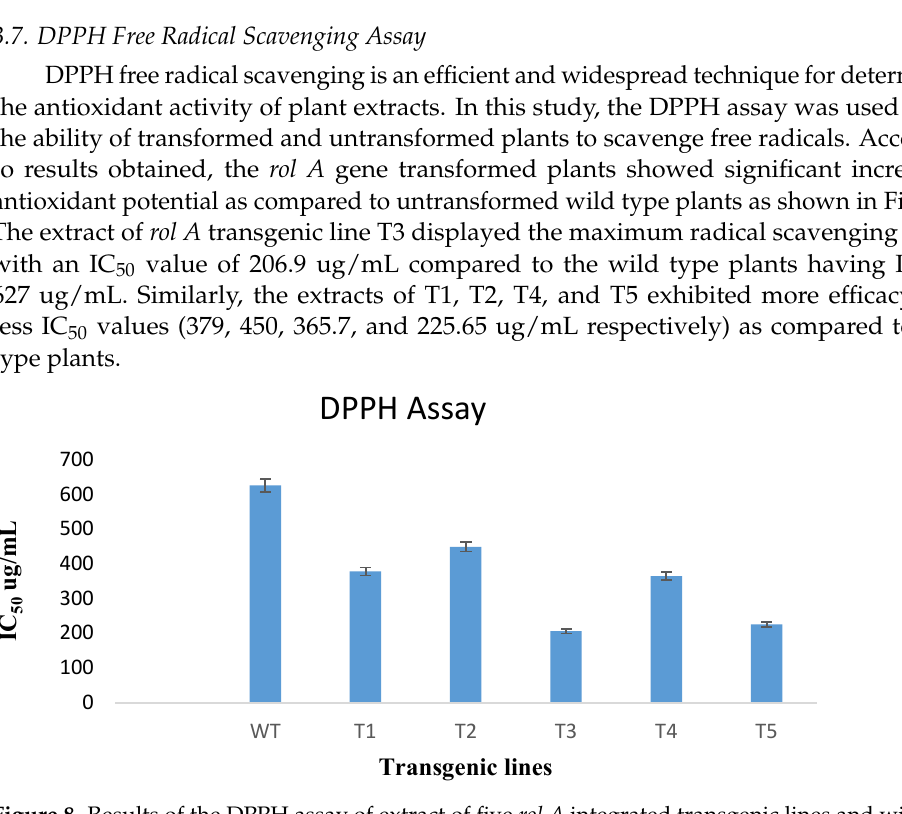
Figure 8. Results of the DPPH assay of extract of five rol A integrated transgenic lines and wild type plant extract